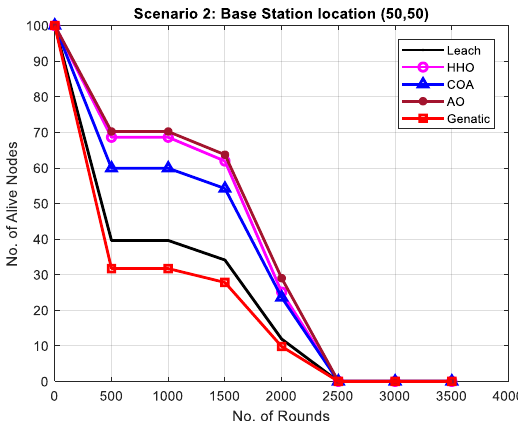
Figure 3. Number of alive nodes in case of scenario 1: BS at (0,0).